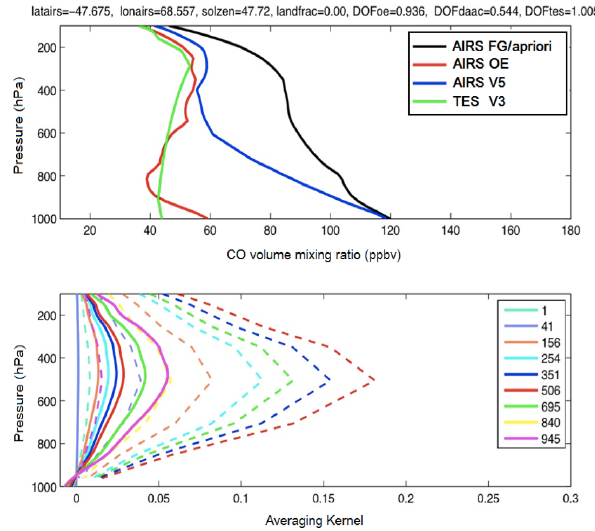
Figure 5. Fig. 5. As in Fig. 4 except for the SH.